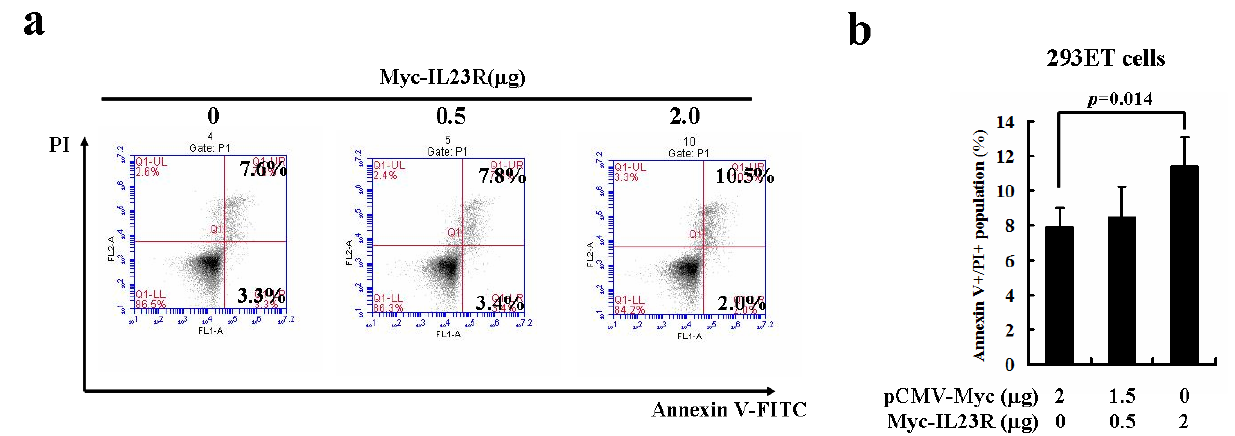
Figure 2. Human IL-23R induced cell apoptosis in human embryonic kidney cell